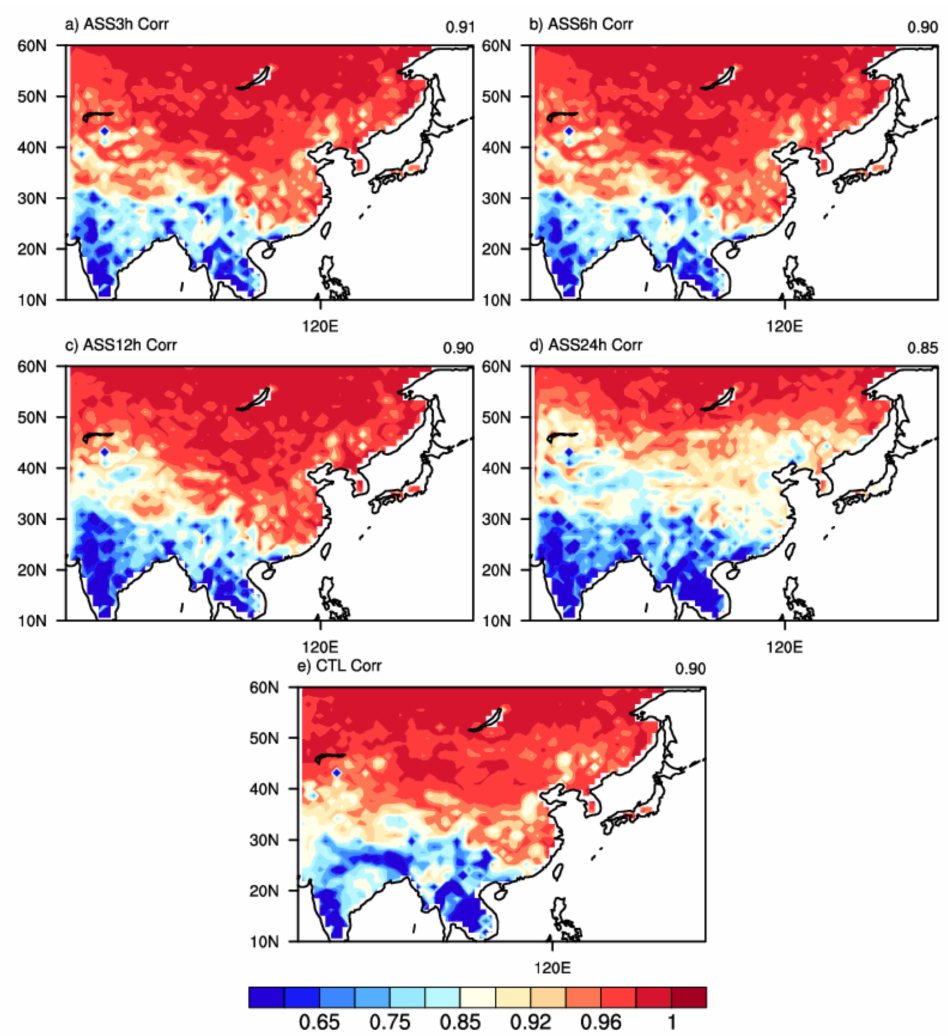
Figure 6. The spatial distributions of the time correlation coefficients between the LST of ( a ) the ASS 3 h experiment, ( b ) the ASS 6 h experiment, ( c ) the ASS 12 h experiment, ( d ) the ASS 24 h experiment, and ( e ) the CTL experiment and the daytime MODIS